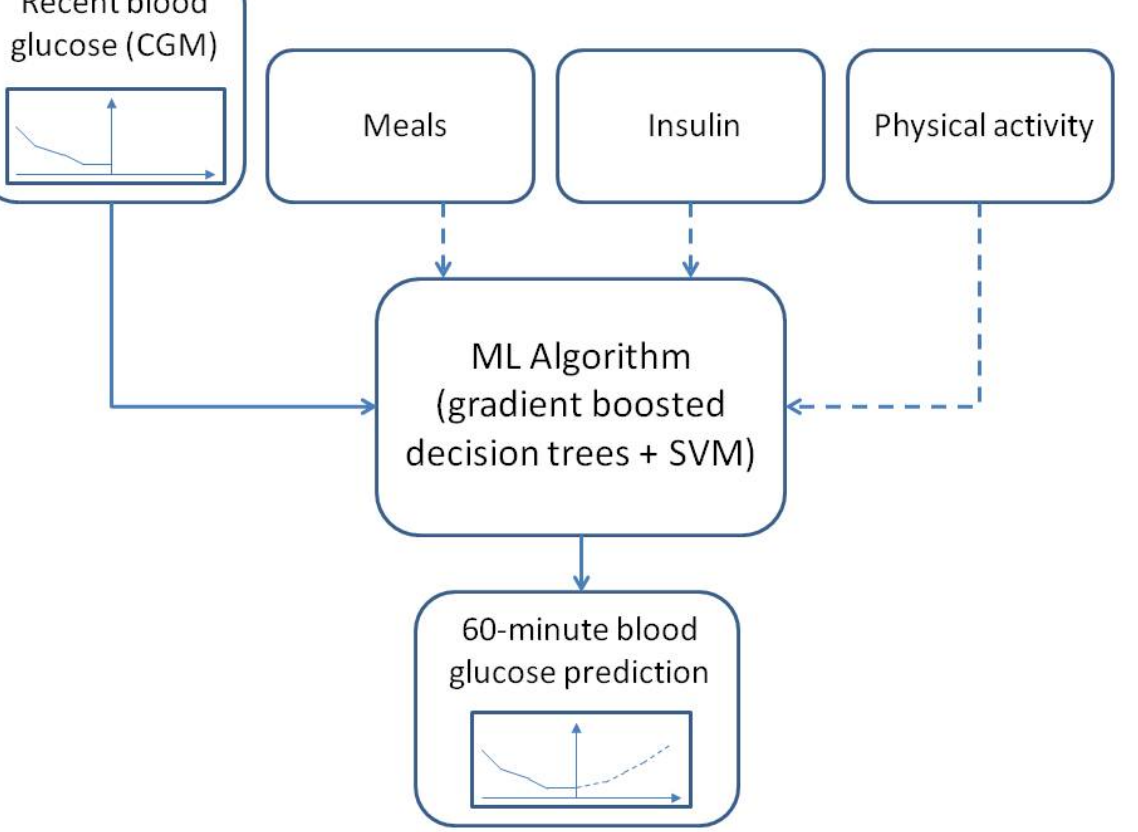
Figure 2. A block diagram of the Diabits predictive module. Solid connections between blocks indicate mandatory data, whereas dashed connections show optional inputs. The dashed line in the bottom block shows the 60-min prediction that was generated by the machine learning algorithm. CGM: continuous glucose monitoring; ML: machine learning; SVM: support vector